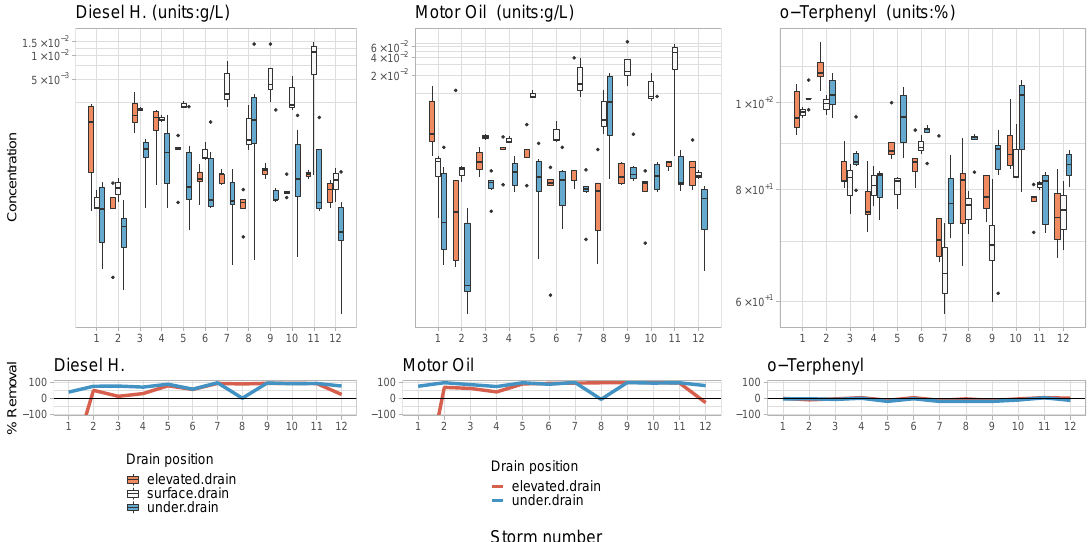
Figure 7. Removal efficiencies for TPHs at elevated drain and under drain positions across measured storms. Removal efficiencies below − 100% (or over 100% export) are not shown, and why Storm 1 elevated drain removals for diesel H. and motor oil are not